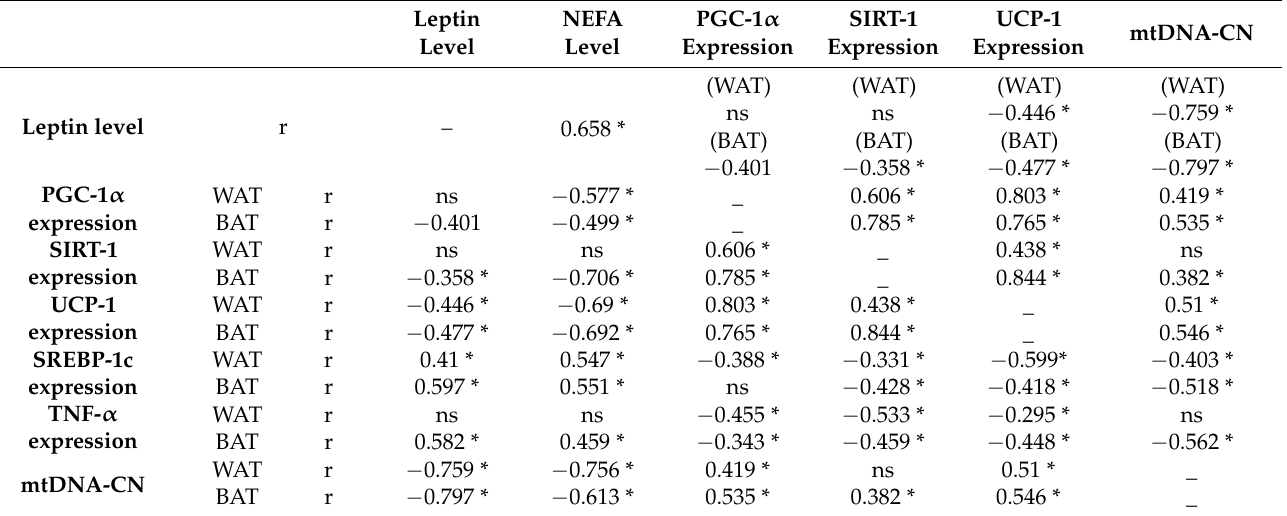
Table 6. Correlation